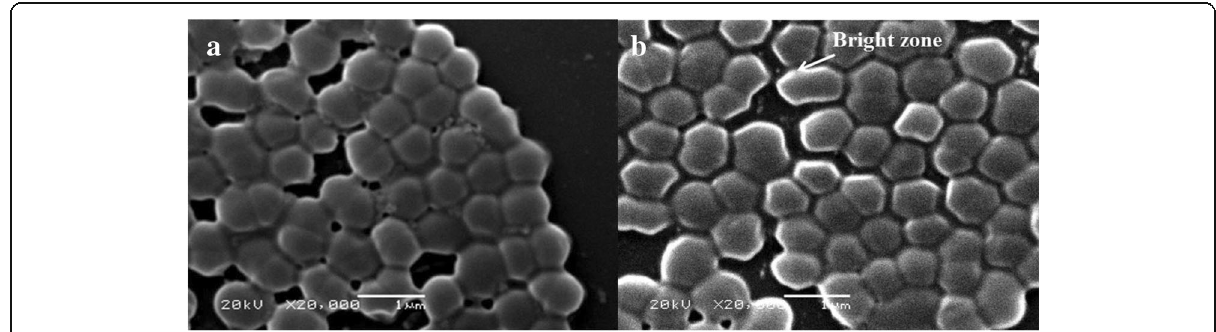
Fig. 2 Transmission electron micrograph of L. lactis cells cultured in the absence ( a ) and presence ( b ) of cholesterol. × 20,000 magnification; scale bars: 1 μ